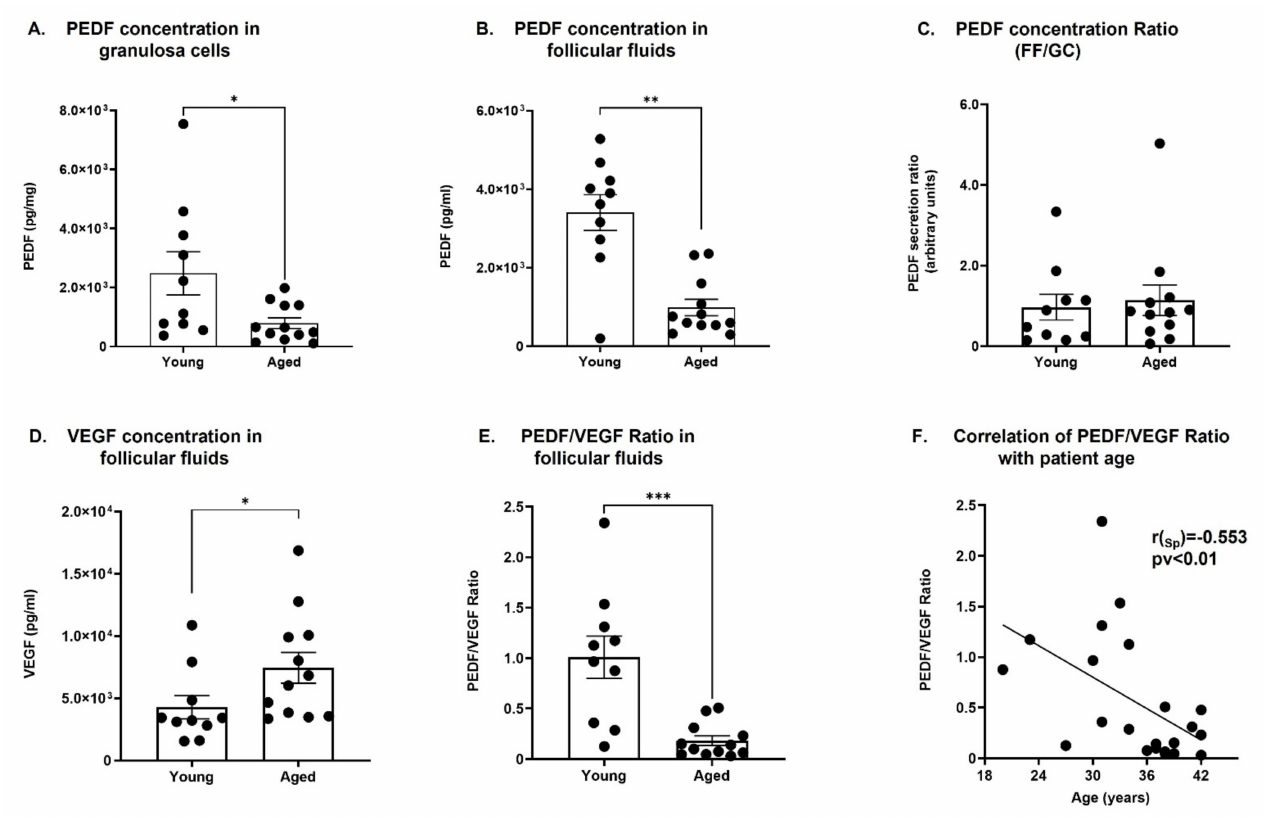
Figure 3. PEDF and VEGF protein in human GCs and in FF. phGCs extracts and FFs of IVF patients: phGCs and FFs of young (“Young”; 20–35 y; N = 10) and RA patients (“Aged”; 36–44 y; N = 11) were collected individually and subjected to specific ELISA assay kits. ( A , B ) The level of PEDF in GCs extracts ( A ) and in their corresponding FFs ( B ). ( C ) PEDF concentration ratio, calculated by dividing the level of PEDF in FFs by its level in GCs. ( D ) The level of VEGF in FFs. ( E ) PEDF/VEGF ratio in FFs. Each black circle represents one patient. Data are presented as mean ± SEM. Results were analyzed by Student’s t -test with Welch’s correction. * pv < 0.05; ** pv < 0.01; *** pv < 0.001. ( F ) Spearman correlation analysis of PEDF/VEGF ratio to patients’